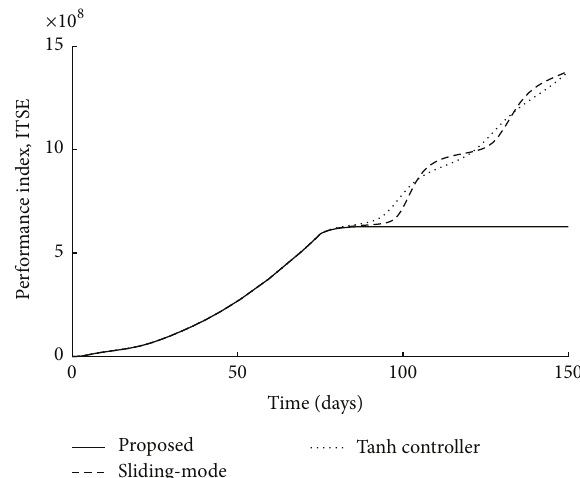
longevity. Also this approach can avoid the drug